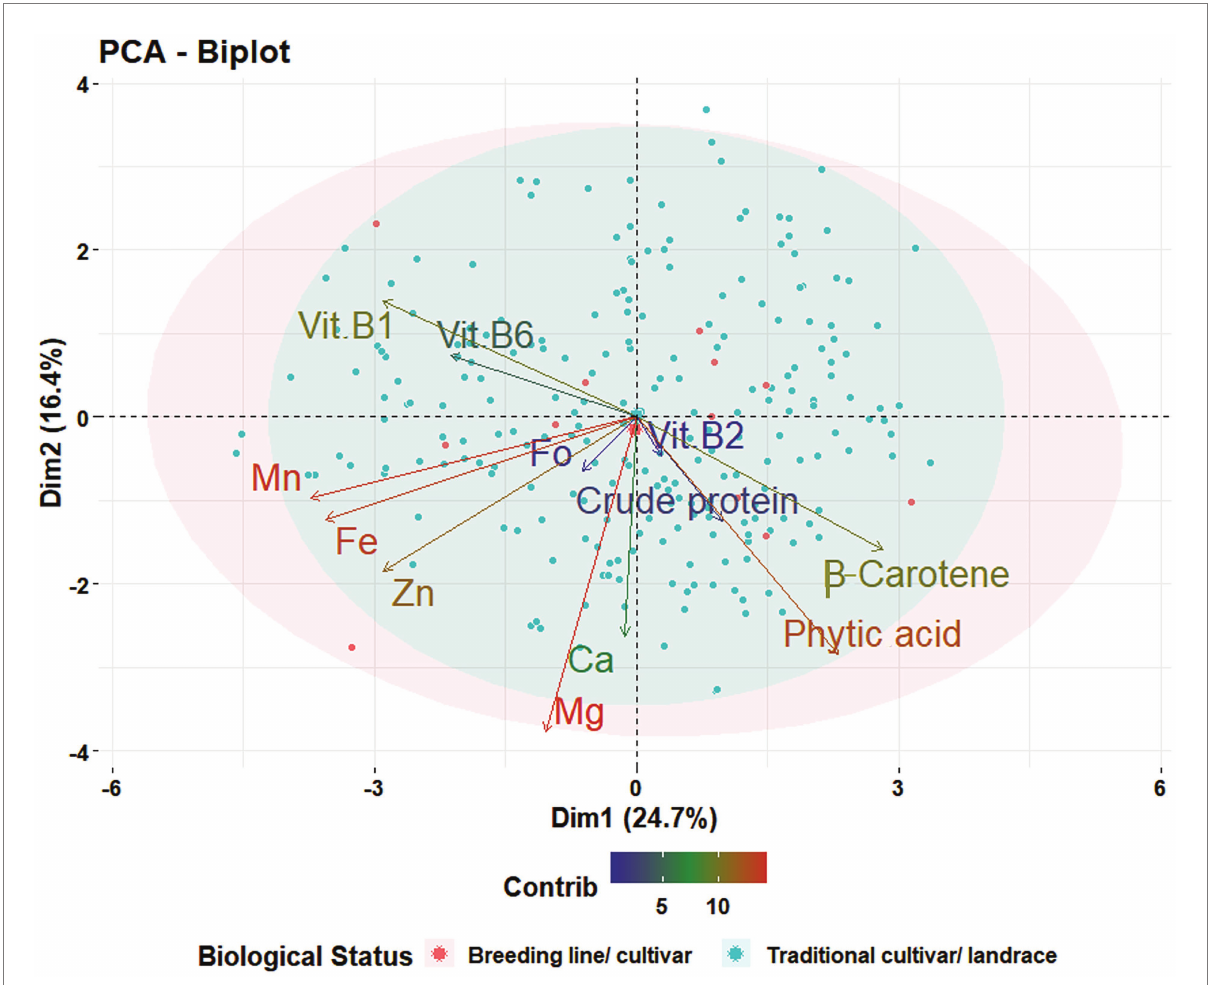
FIGURE 2 Principal component analysis for 12 nutritional traits. Projection of 258 accessions in the reference set on the first plane of principal component analysis using phenotypic data for 12 traits [ β -Carotene, calcium (Ca), crude protein, folate (Fo), iron (Fe), magnesium (Mg), manganese (Mn), phytic acid, vitamin B1 (Vit B1), vitamin B2 (Vit B2), vitamin B6 (Vit B6), and zinc (Zn)]. The first two components, PC1 and PC2, explain 41.1% of the variance between